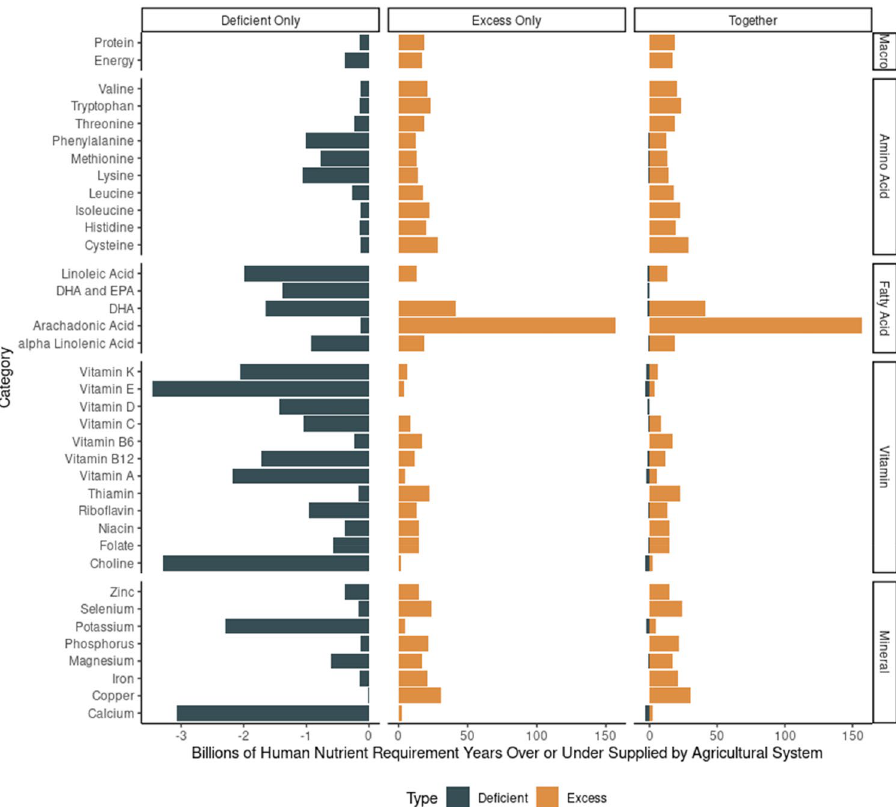
Figure 2. Comparison of nutrient provision (excess or deficient relative to population requirements) based on individual country data, summed to yield global supply estimates. Supply estimates used the P4 representation, which accounts for losses associated with waste and animal feed usage, along with changes in balance associated with trade. Values reflect the billions of human nutrient requirement years that are either over-supplied or under-supplied by the agricultural system, when supplies are scaled to the requirement of each country’s population. Nutrient deficiencies and excesses are shown on different panels for readability and on the same panel for scale